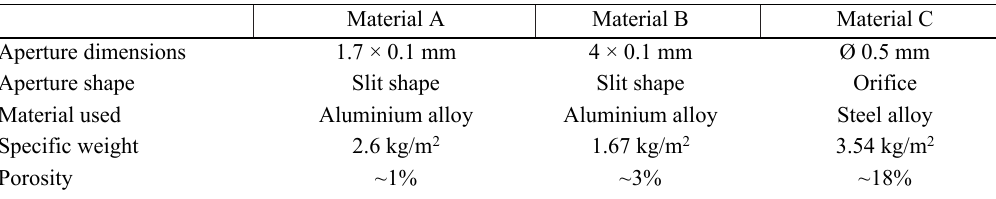
Fig. 1. Material samples (d = 28 mm) tested: material A; material B; material Table 1. Properties of tested materials